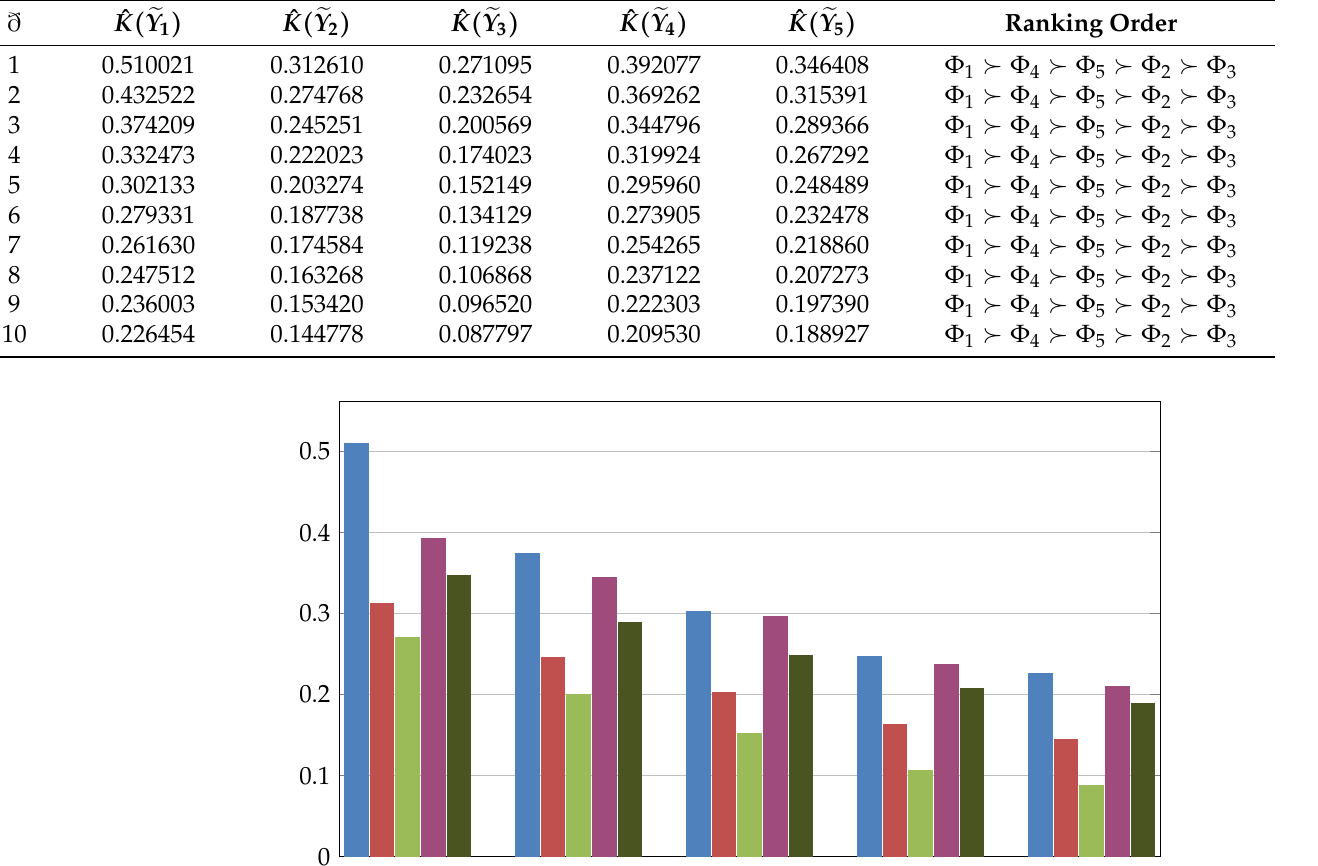
Table 3. Ranking order of the alternatives with various parameter ð by IVIFAAWG operator.